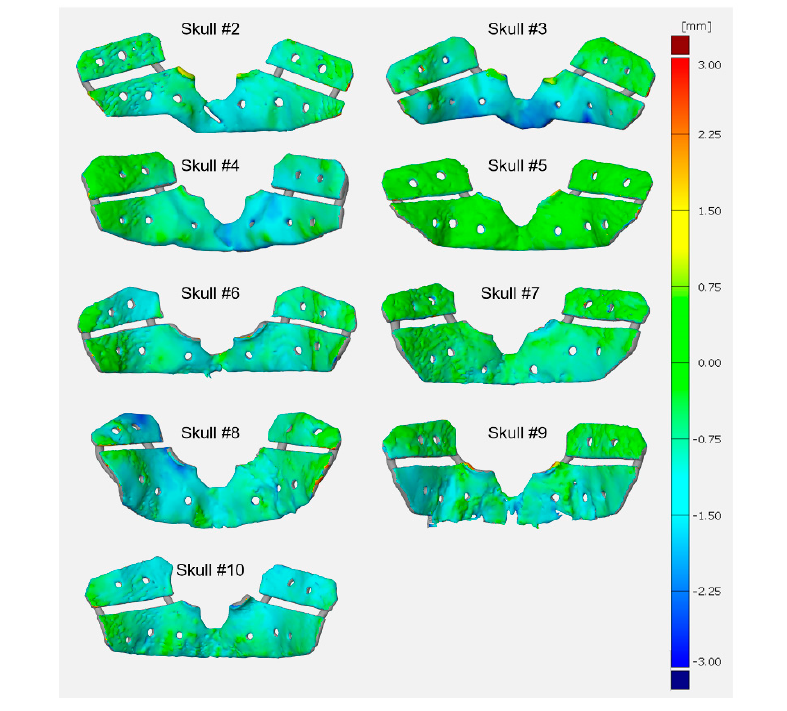
Figure 5. 3D color di ff erence map of fitness of the template for skull #2 to skull #10.